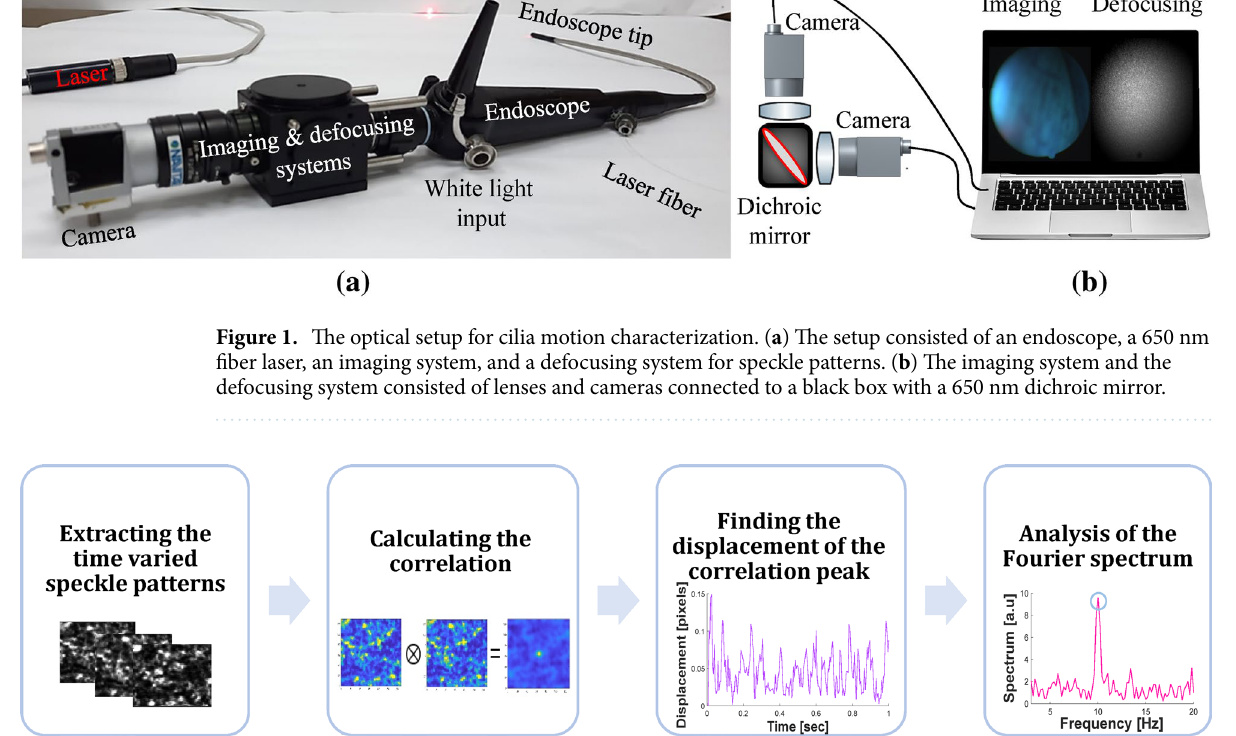
Figure 2. Flow chart of the image processing algorithm for monitoring cilia motion frequency